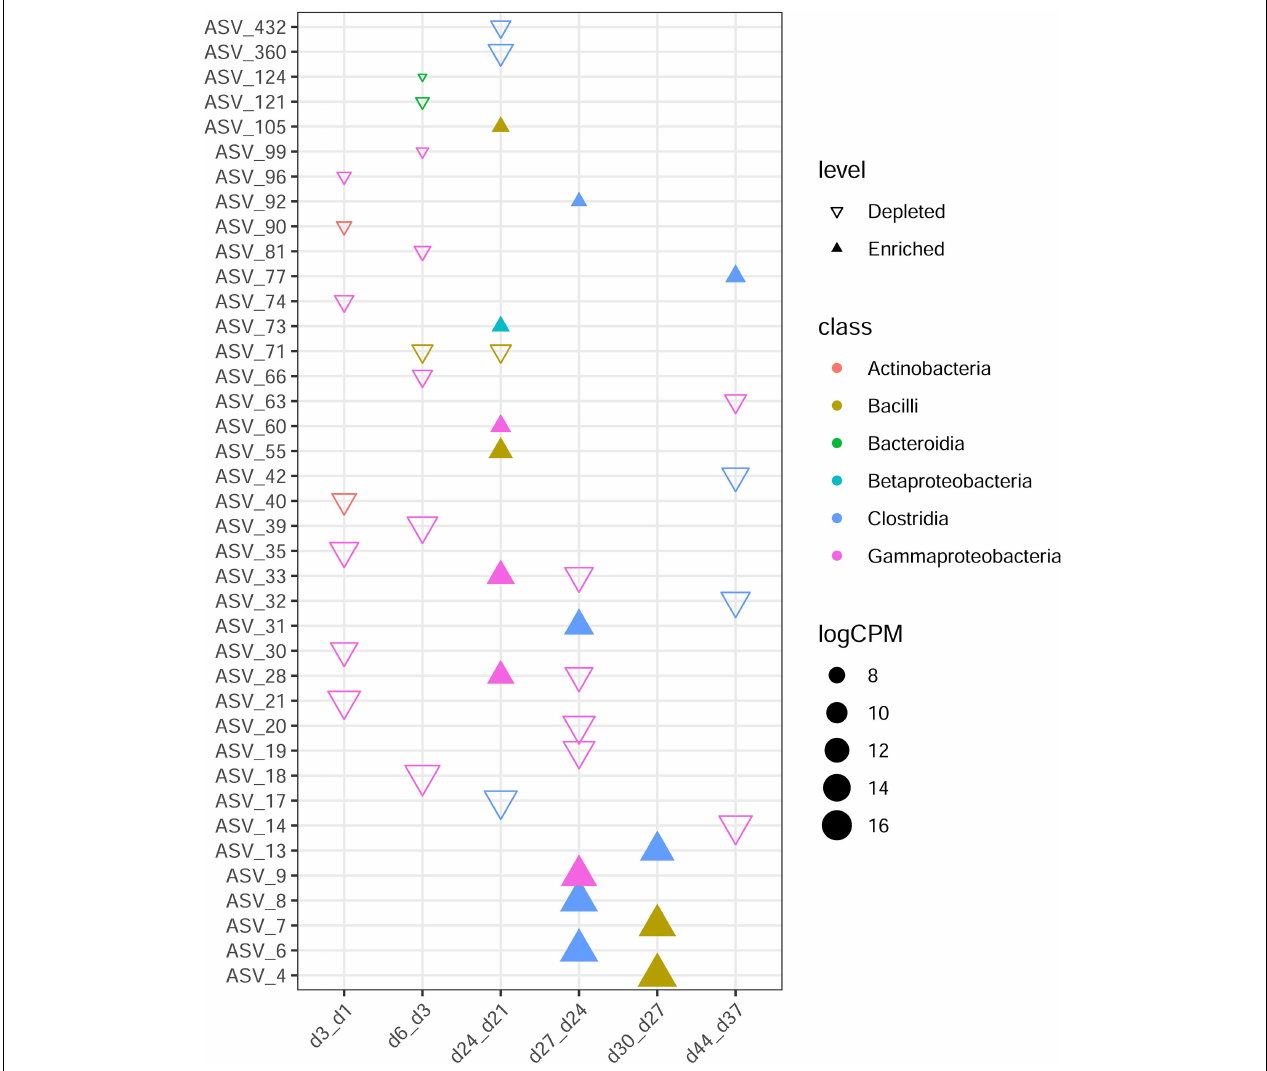
FIGURE 3 | Differences in ASV abundance between two closest ages. The samples of the former time point were taken as control of the latter time point. Each triangle represents a single ASV with adjusted P value < 0.05 and | logFC| > 2. Enriched in older age are revealed by filled triangles and hollow triangles shown ASVs enriched in younger age group. ASVs are colored by their class. CPM denotes count per